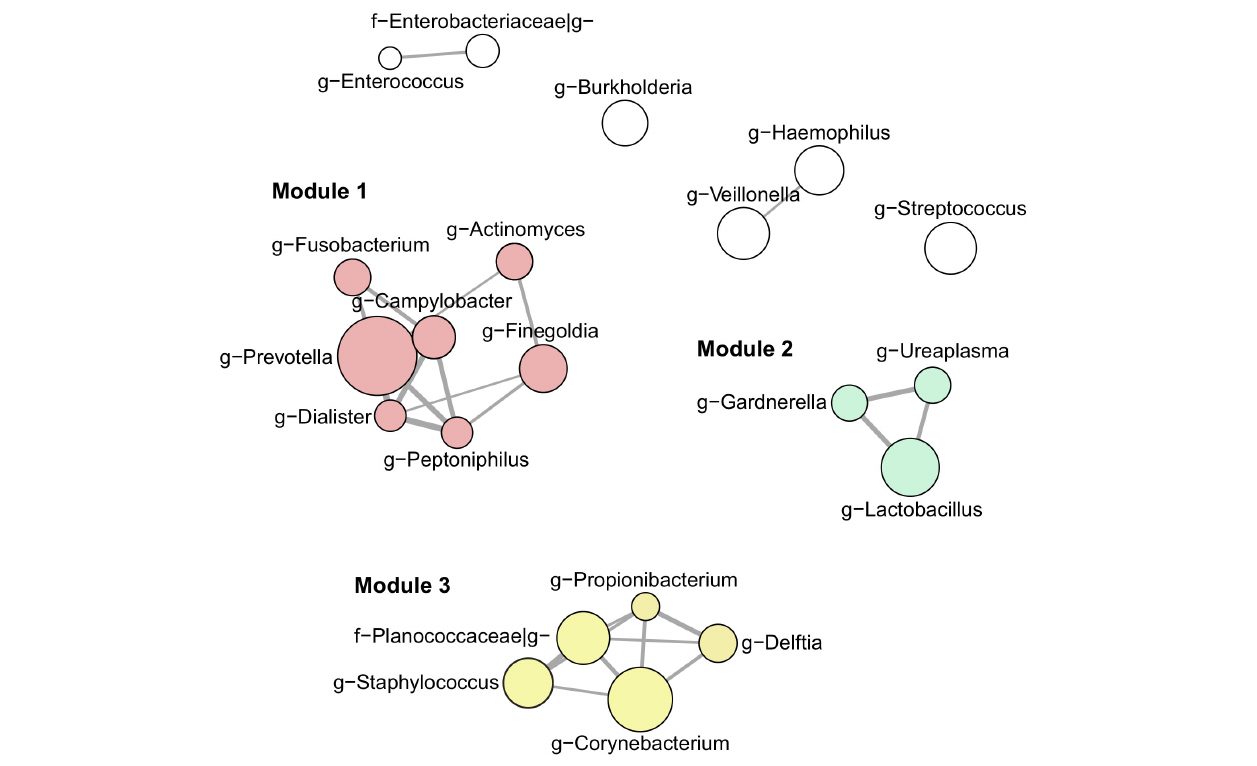
FIGURE 3 | Interaction network of the most abundant genera ( > 1% mean relative abundance) using SparCC algorithm. Connecting edges represent significant interactions (one-sided p -value < 0.05) with thickness proportional to SparCC co-occurrence values. Nodes are sized according to mean relative abundance of the corresponding genus in the data set. Members of interaction module 1, 2, and 3 are highlighted in red, green and yellow, respectively.